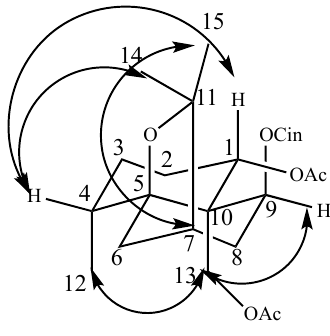
Figure 5. Key NOESY correlation of Compound 2 .